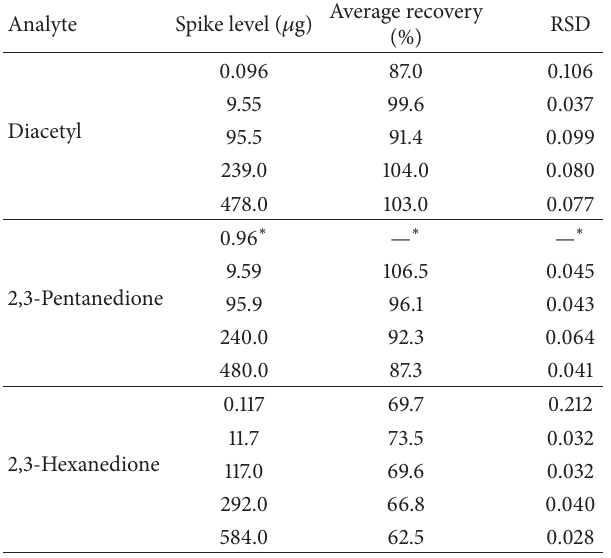
Table 3: Limit of detection (LOD) and Limit of Quantitation (LOQ) for alpha-dicarbonyl compounds .